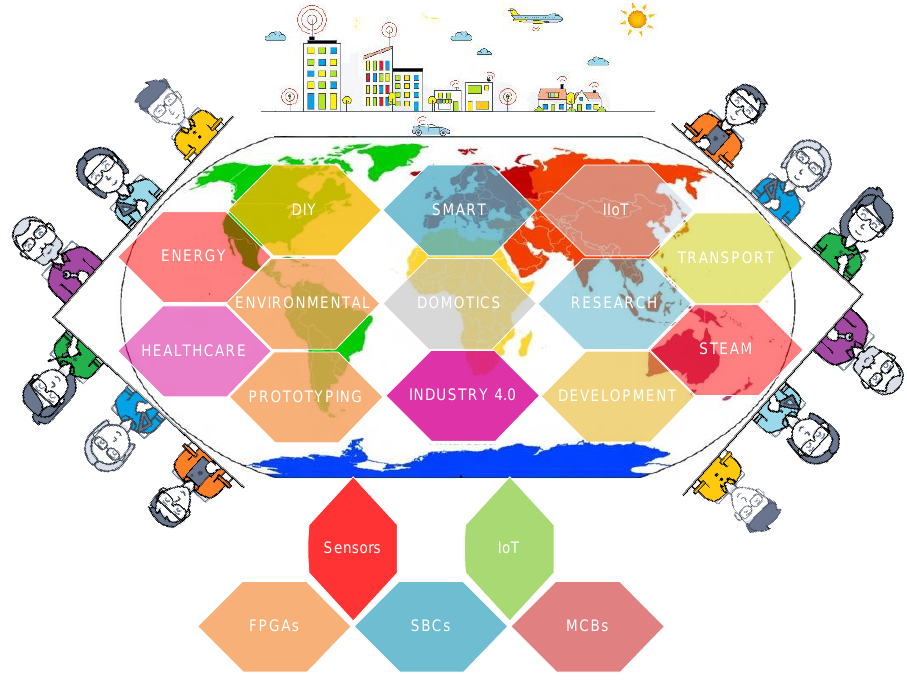
Figure 1. Applications of Single Board Architectures Integrating Sensors Technologies.